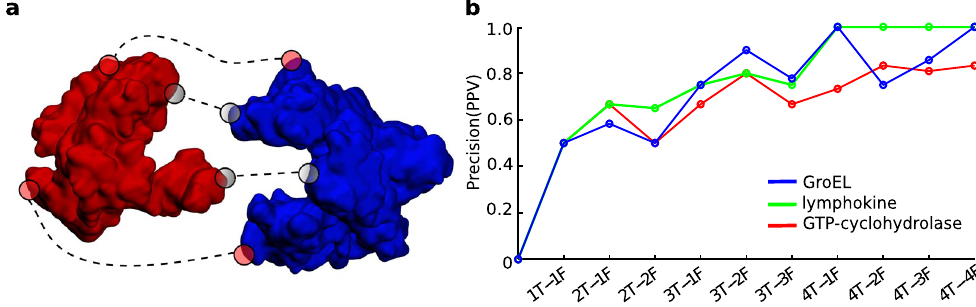
Figure 3. Detection of wrong constraints using mViE. ( a ) Protein-protein interaction example where 4 interfacial residue contacts are used as inputs, in this case 2 of these constraints are correct (grey colored circles) and two are erroneous (red colored circles). ( b ) Wrong constraints inclusion effect on returned model quality. The quality of the models was assessed by calculating the Precision/Positive Predictive Value [PPV = TP/(TP + FP)] representing how well good constraint (TP) were correctly satisfied in the returned models against wrongly satisfied “bad” constraints (FP). On the x-axis, the 1T-1F label means that 1 correct and 1 wrong spatial constraints were used during the optimization